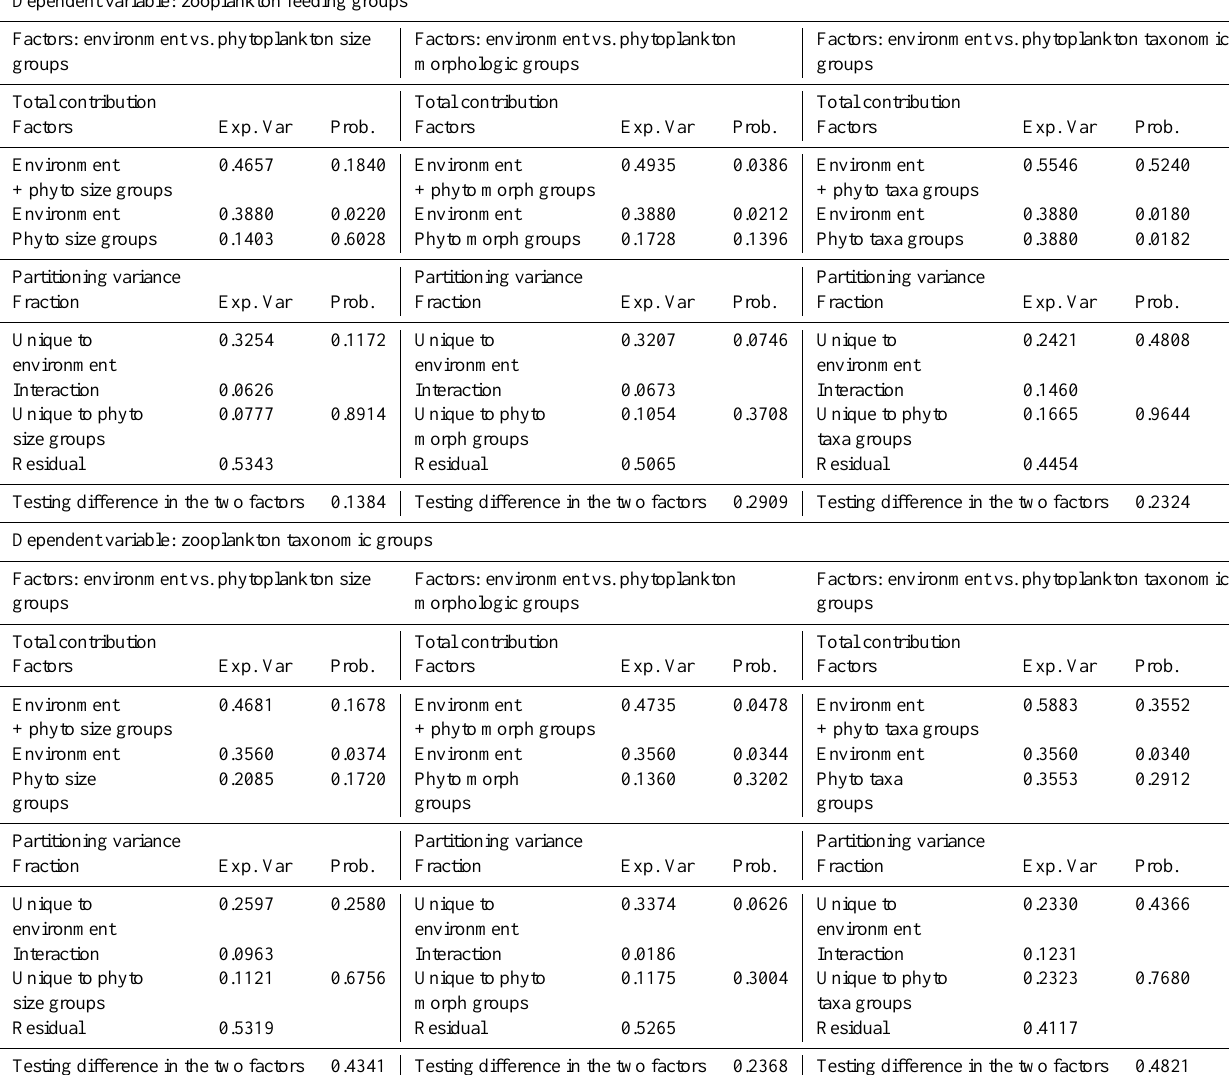
Table 5. Results of variance partition to investigate the relative contribution of environmental and phytoplankton matrices in explaining the variation of zooplankton